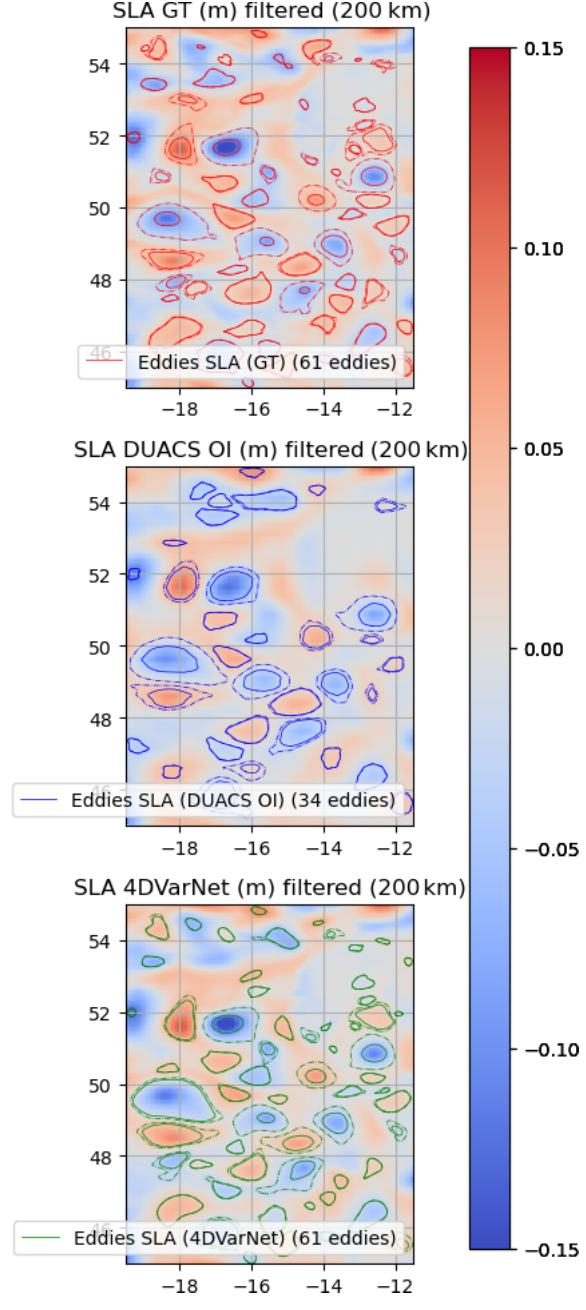
Figure C5. Eddies detected on the OSMOSIS domain (25 October 2012) over SSH (one SWOT plus four nadirs).